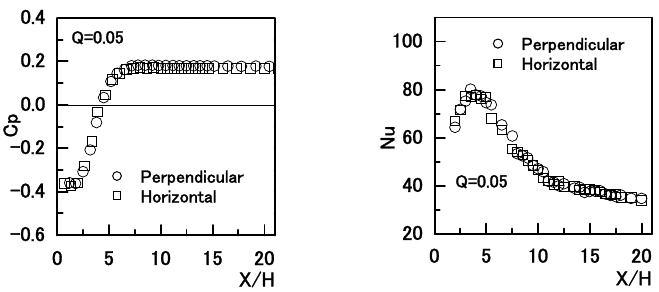
Fig. 4 Wall static pressure coefficient and Local Nusselt number